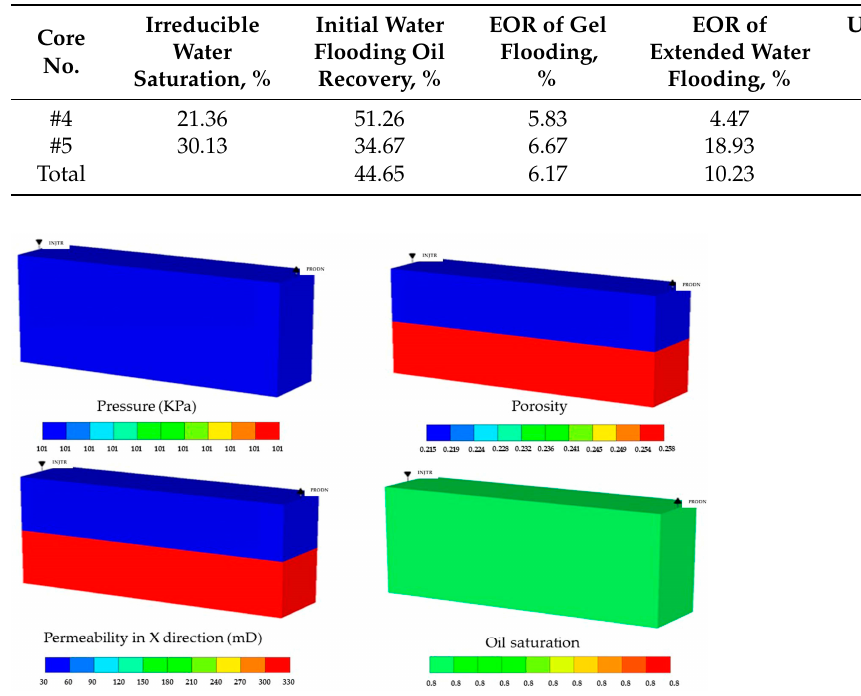
Figure 6. The distribution of initial pressure, porosity, permeability, and oil saturation in the gel flooding experimental model.